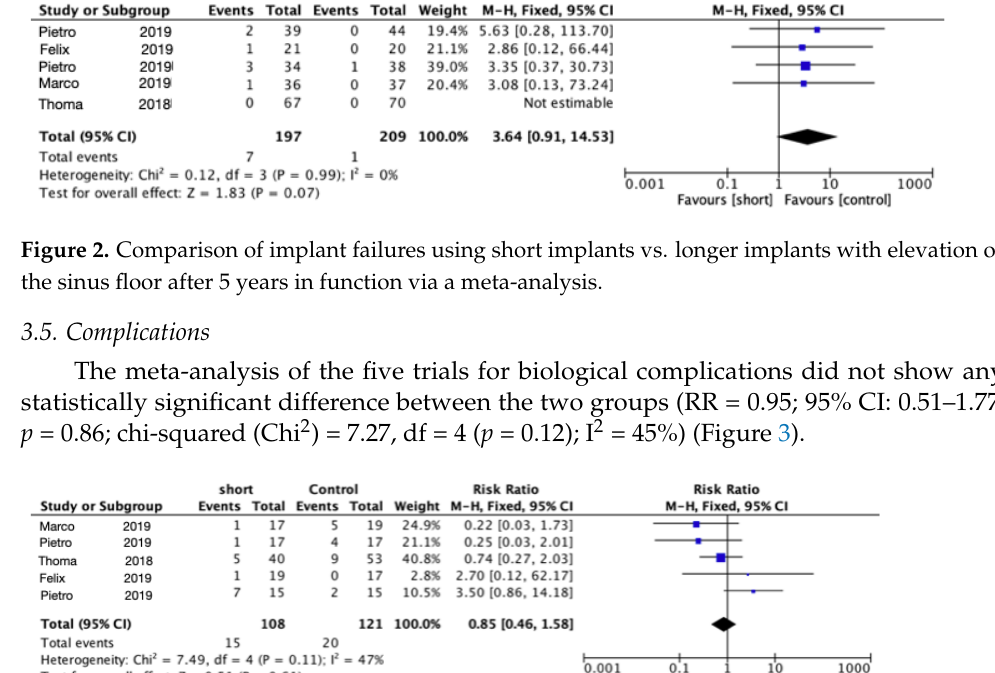
Figure 2. Comparison of implant failures using short implants vs. longer implants with elevation of the sinus floor after 5 years in function via a meta -analysis.